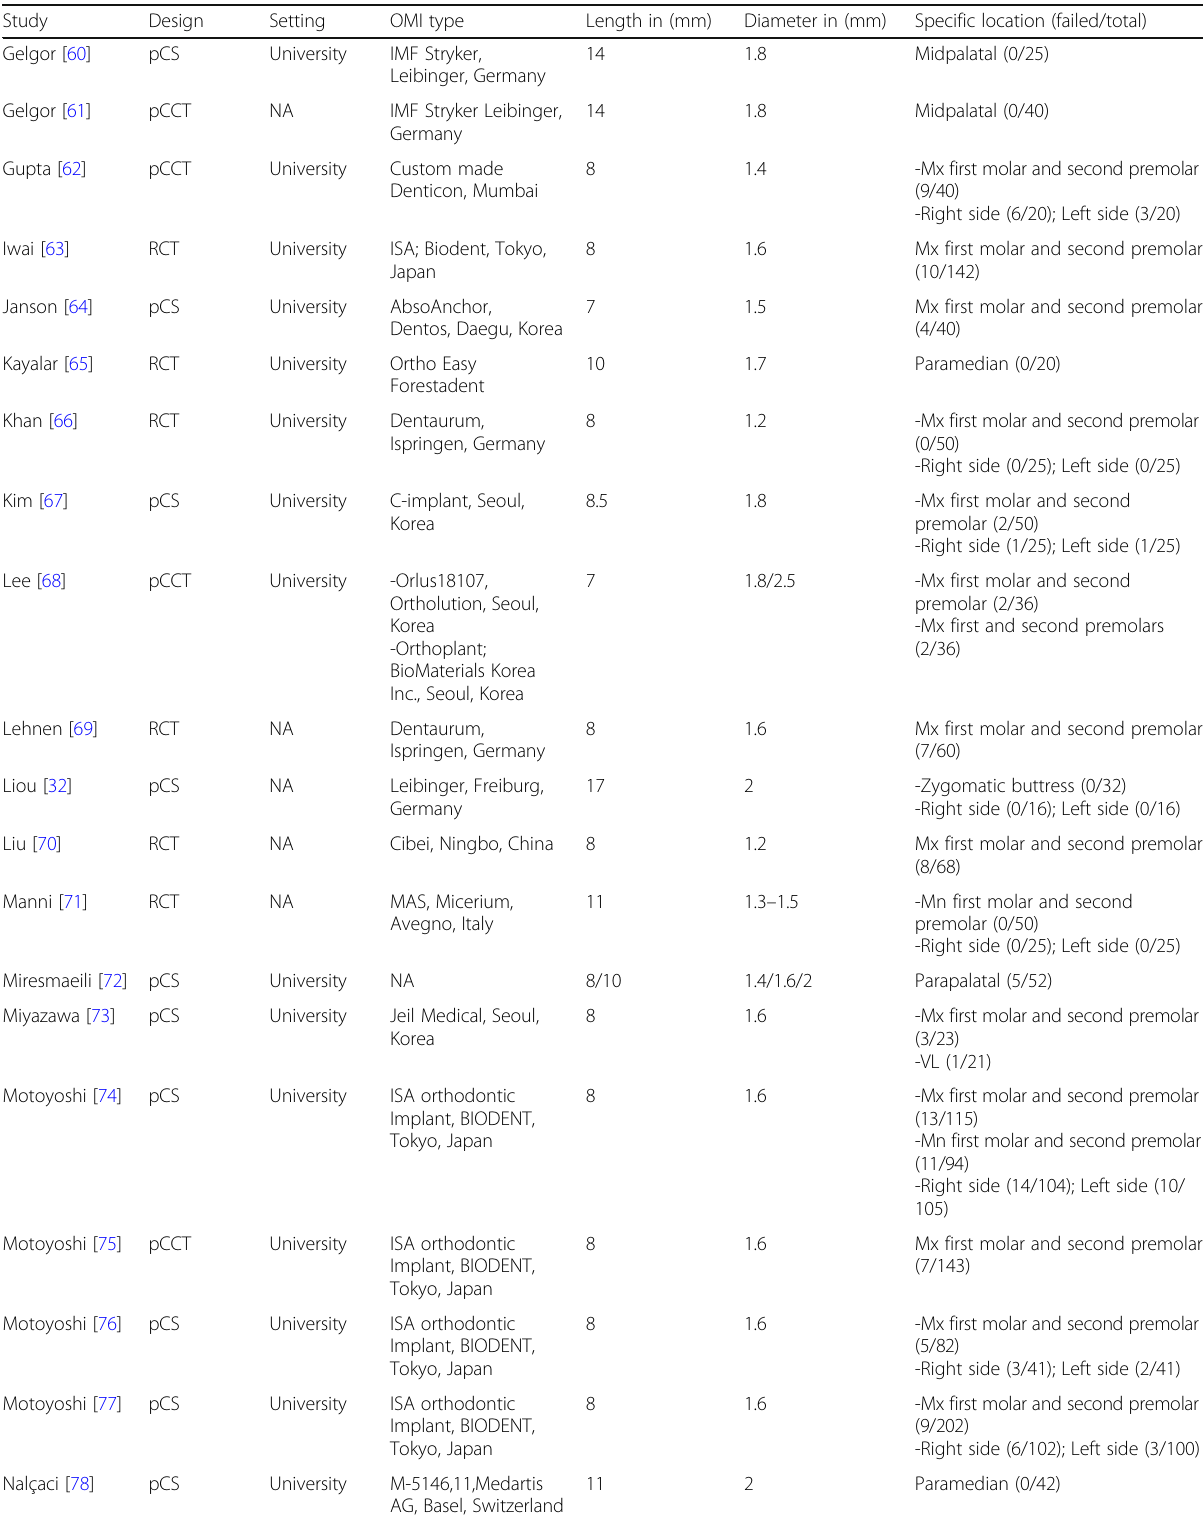
Table 1 Characteristics of the included studies